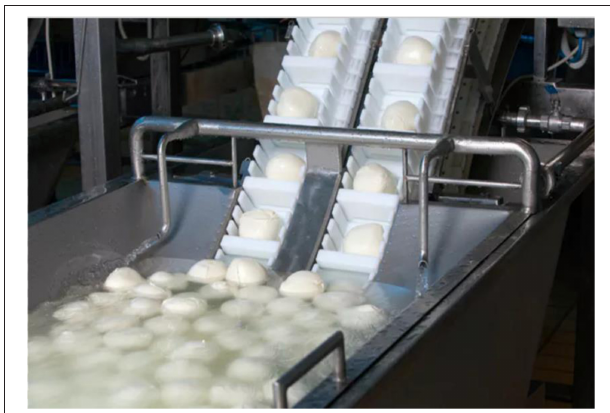
FIGURE 1 | Production of lactobionate in a cheese factory (Shutterstock.com/ Giuseppe